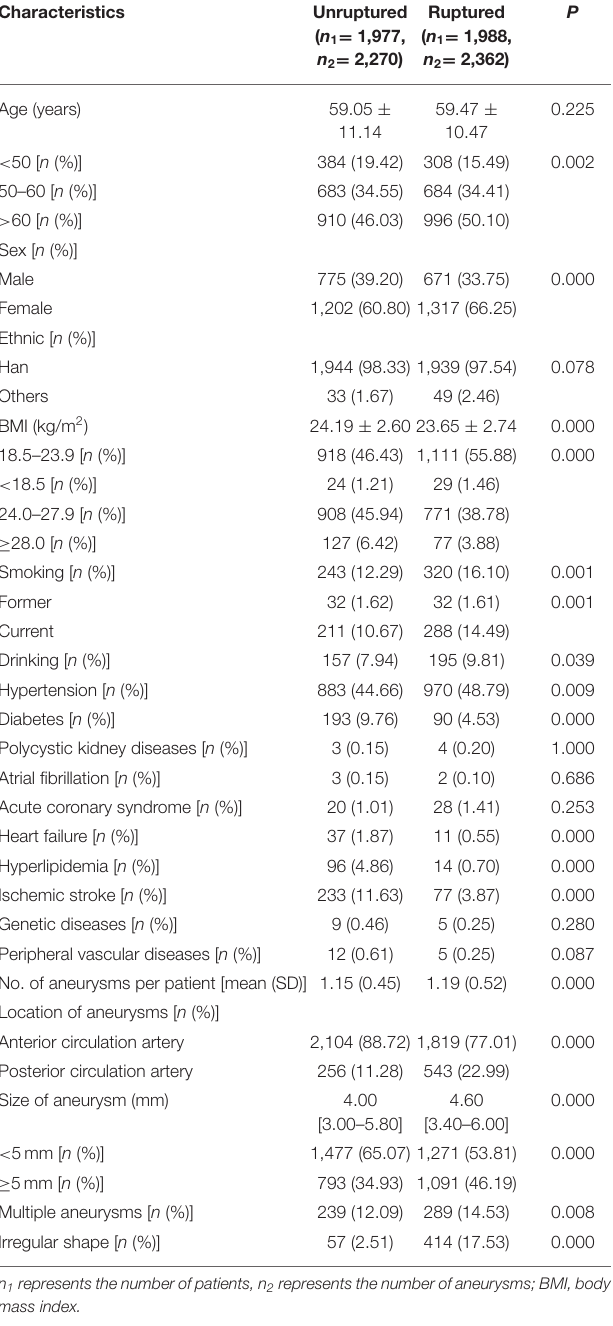
Aneurysmal parameters included the number, maximum size, shape irregularity, and location of intracranial